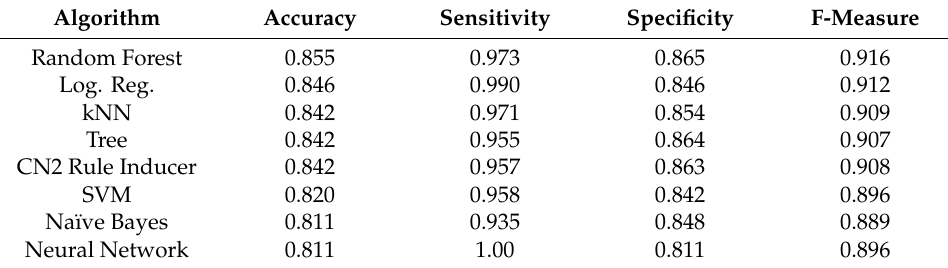
Table 5. Data transformation (equal width), feature selection (none).